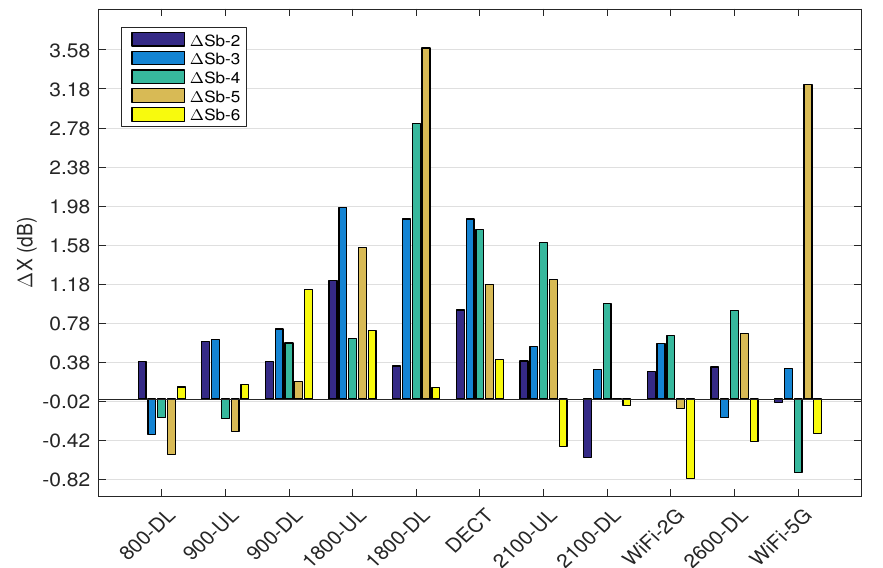
Figure 8. difference in CI 68 for subjects Sb-2 to Sb-6 with respect to